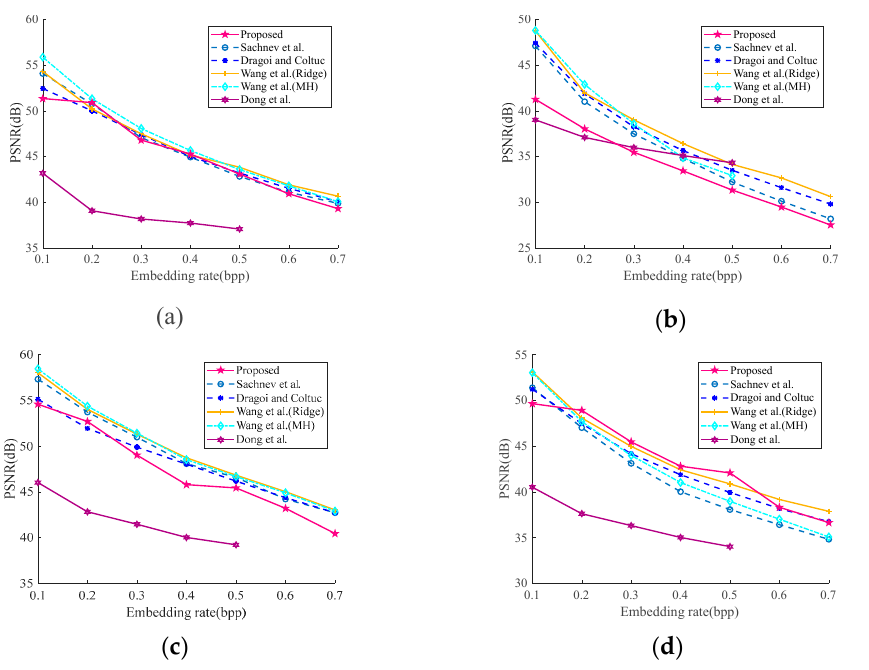
Figure 12. The capacity–distortion performance comparison: ( a ) Lena; ( b ) Baboon; ( c ) Airplane; ( d ) Boat.